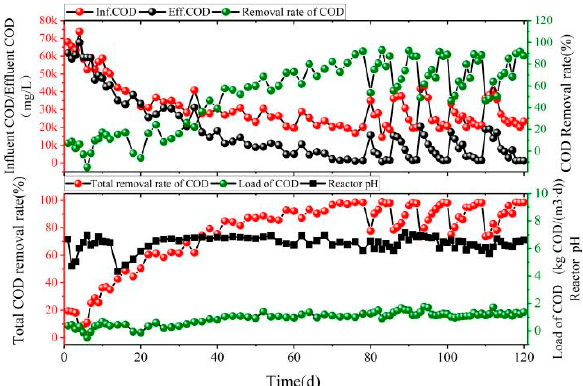
Figure 3. EGSB microscopic anaerobic segment operating parameters.